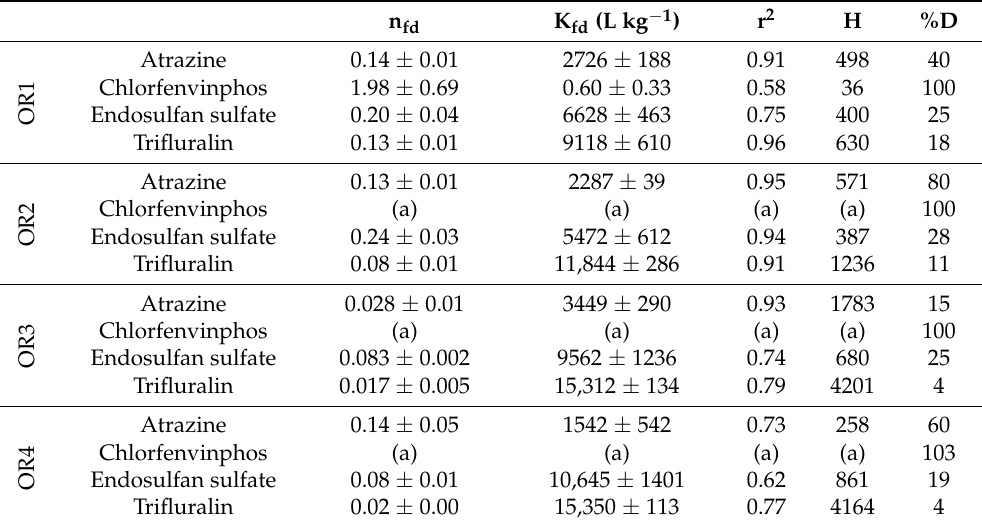
Table 4. Desorption parameters (OR1 = sawdust, OR2 = chicken manure, OR3 = orujillo, OR4 = composted urban solid